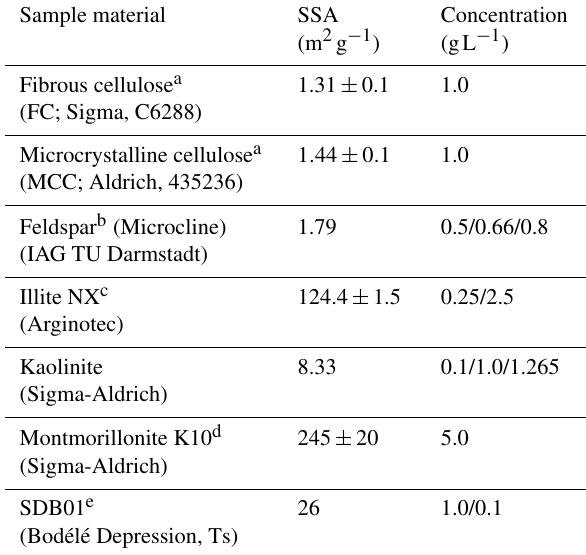
Table 1. Aerosol material and sources measured in the current study. Also given are the specific surface area (SSA) and the con- centrations used for the immersion freezing experiments in the M- AL and in